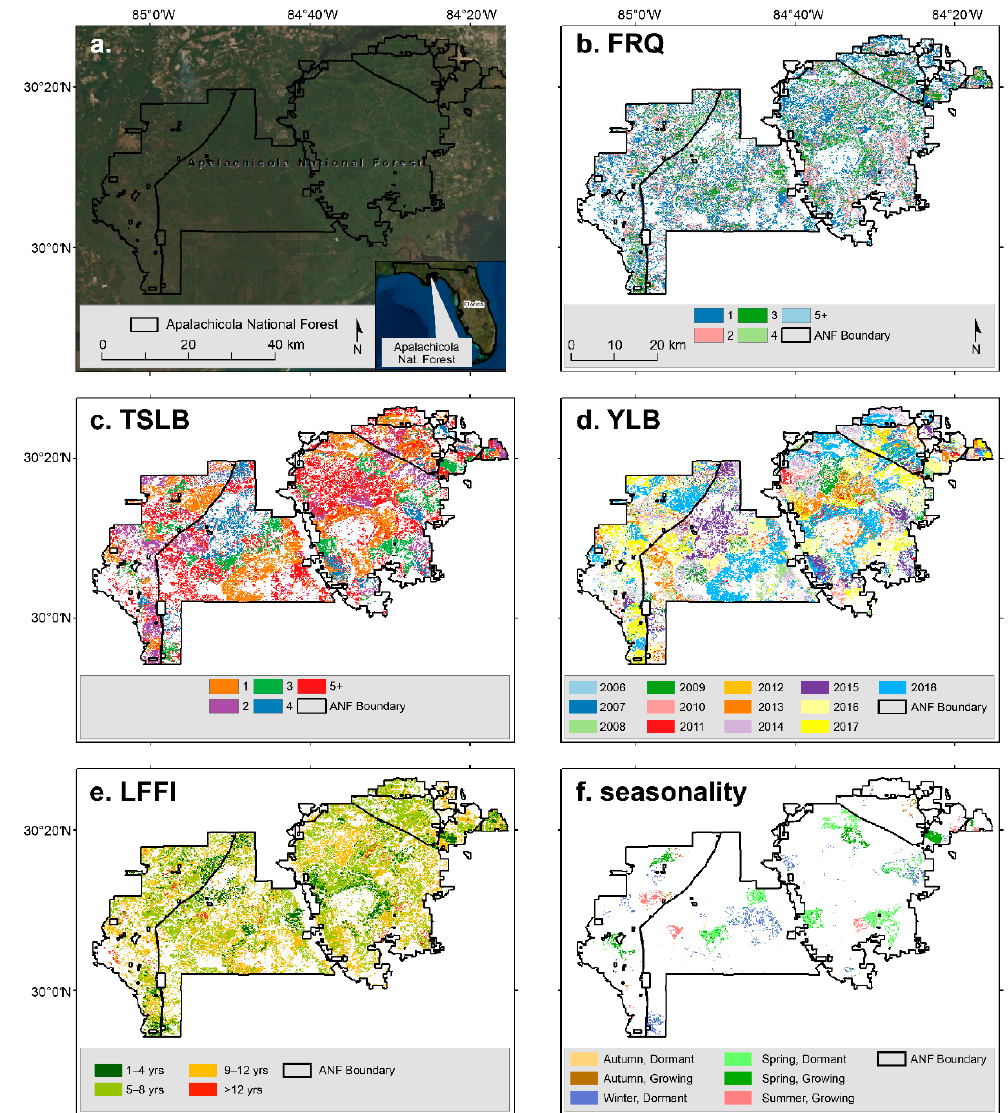
Figure 4. Fire history metrics derived for the ( a ) Apalachicola National Forest (ANF) spanning the Table 2006 to 2018 illustrate that landscape patterns are easily discerned. Fire metrics derived from the Landsat burn probability products include: ( b ) the number of times burned (FRQ), ( c ) time since last burn (TSLB) in years, ( d ) year last burned (YLB), and ( e ) longest fire-free interval (LFFI); and ( f ) the seasonality of burning for the year 2016 was derived from the burn date prod- ucts.